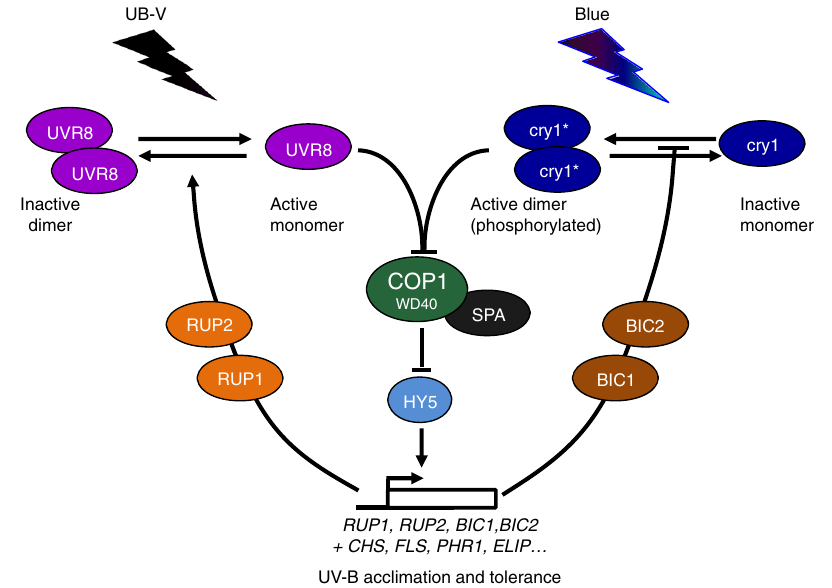
Fig. 6 Working model for the molecular integration of UVR8 and cryptochrome signalling. Light activation of UVR8 and cry1 leads to inhibition of the COP1-SPA E3 ubiquitin ligase complex, which releases HY5 from its repression through ubiquitination and proteasomal degradation. The transcriptional activator HY5 induces the expression of genes such as those associated with UV-B acclimation and tolerance (biosynthesis of sunscreen metabolites, DNA repair, photoprotection, etc.). HY5 also induces genes encoding distinct proteins with regulatory roles that concurrently provide feedback regulation of UVR8 and cryptochrome photoreceptor activities (note that the control of cry1 activity by UV-B through UVR8 signalling remains to be demonstrated). BIC1 and BIC2 are thought to mainly block cry1 homodimerization, whereas RUP1 and RUP2 are thought to primarily facilitate UVR8 re-dimerization (although additionally blocking UVR8 monomerization cannot be